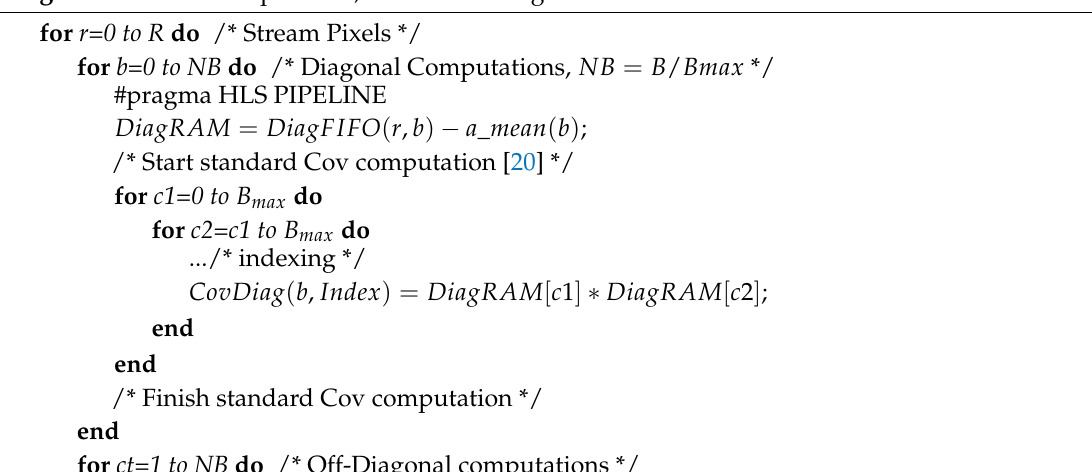
Algorithm 3: Cov computation,